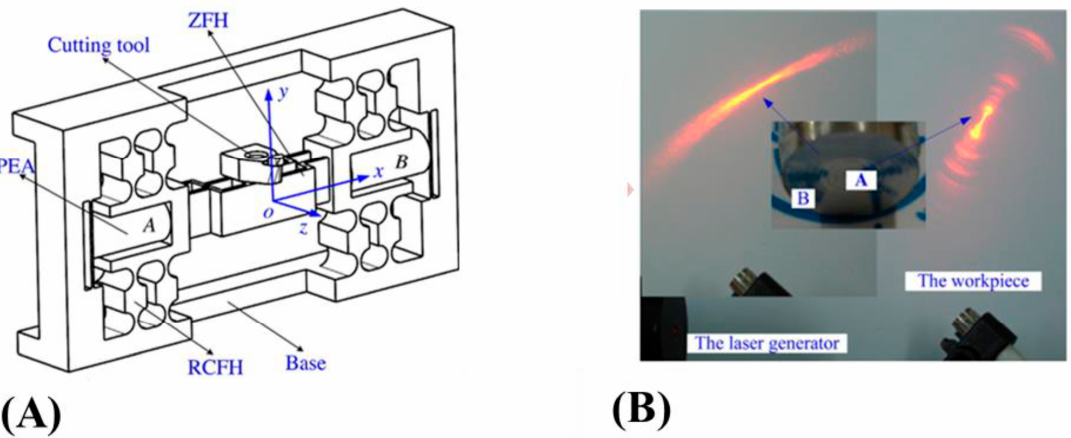
Figure 18. Example of multiple DOF FTS. ( A )FTS with z-shaped flexure hinges [126]. ( B ) On its right are 2 surfaces, Side labelled A is machined using the z-shaped flexure hinged FTS and B is machined with a conventional FTS. A has a lesser light scattering effect compared to B which therefore indicates the machining superiority of the multiple DOF FTS over the conventional